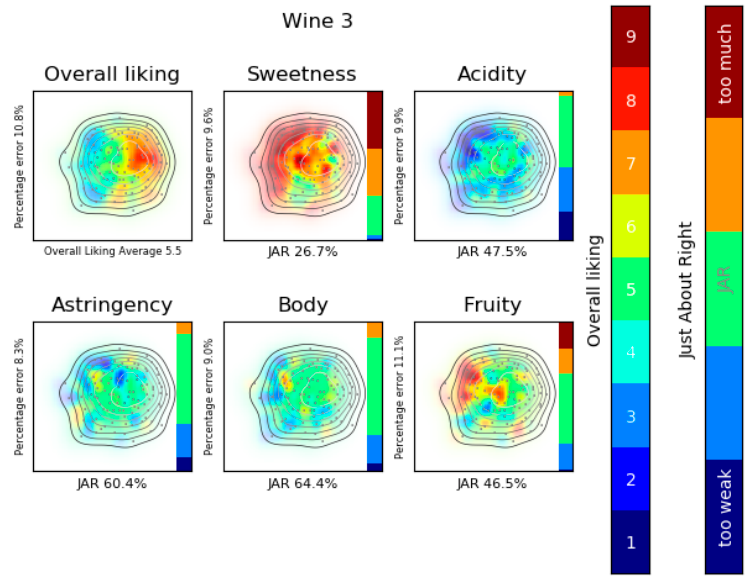
Figure 9. Analysis: Wine 3. Liking product landscape, consumers’ map created with MDS fed with OLJAR and product acceptance map created with SVM.